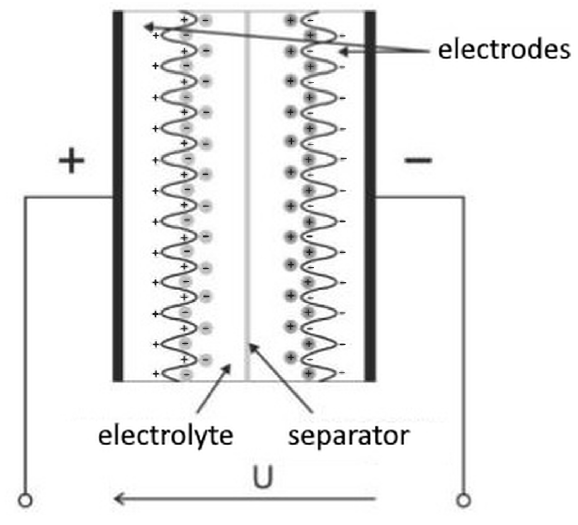
Figure 33. Formation of double layers in a charged supercapacitor [36].